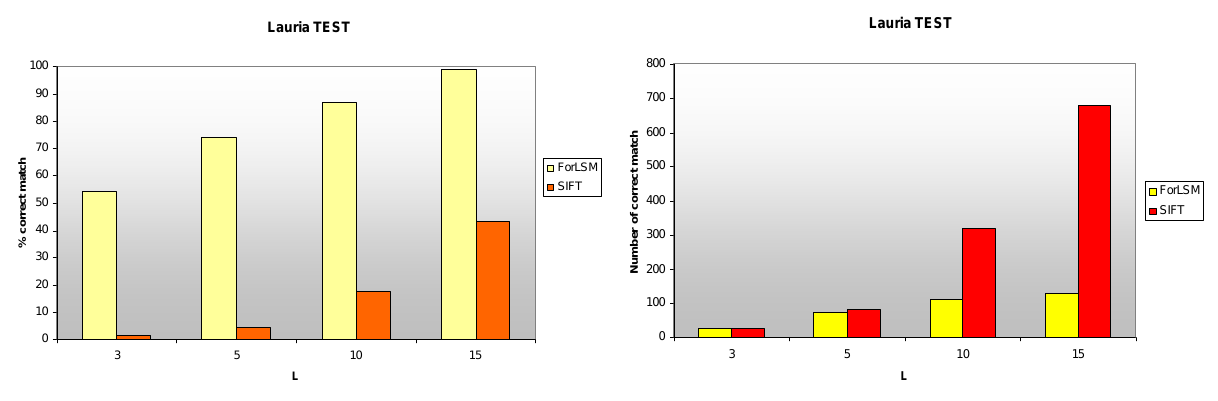
Figure 2. The rate and total number of correct correspondences found with ForLSM and SIFT in the Lauria test images, for different rejection threshold values. Lauria TEST